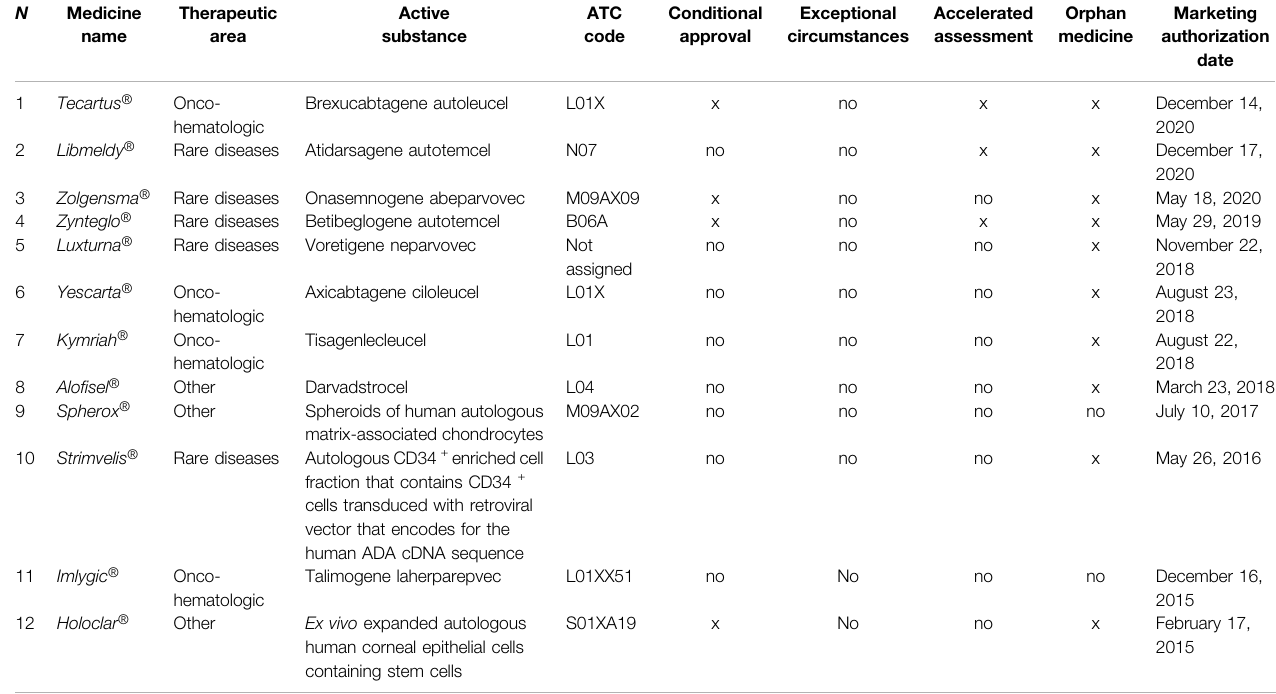
TABLE 1 | ATMPs in Europe and their approval